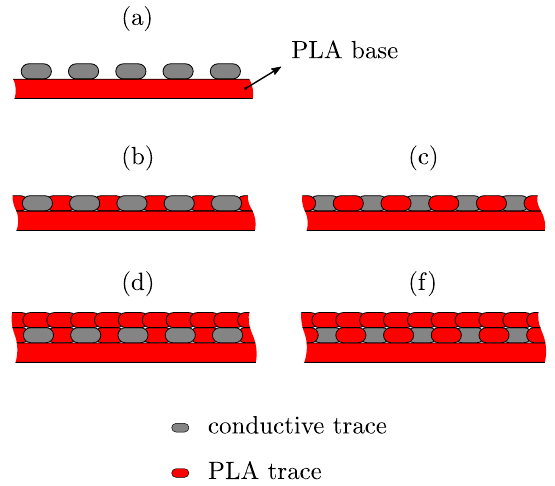
Figure 7. Different embedding of conductive and insulating traces: ( a ) without PLA insulation, ( b ) insulating PLA traces between conductive traces (conductive traces printed first), ( c ) insulating PLA traces between conductive traces (insulating traces printed first), ( d ) variation of ( b ) with insulating overprint, ( e ) variation of ( c ) with insulating